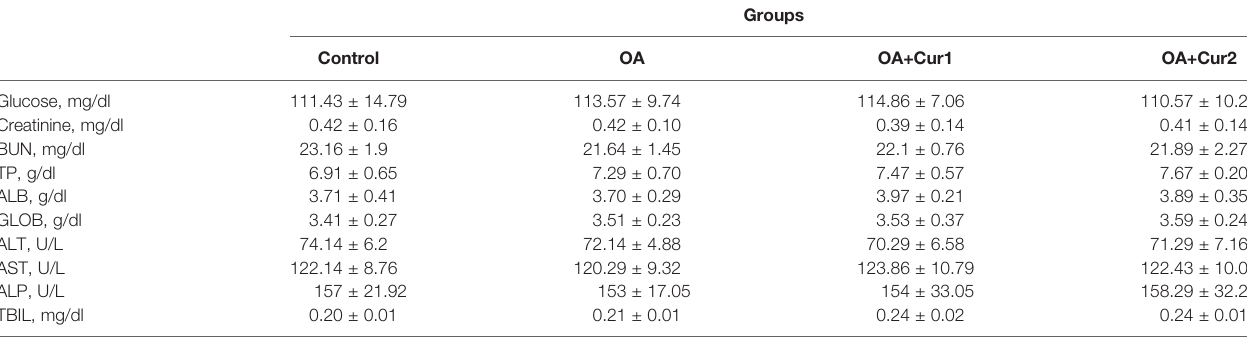
TABLE 2 | Effects of two different doses of NGUC supplementation on biochemical parameters in the serum of rats with monosodium iodoacetate (MIA)-induced OA.